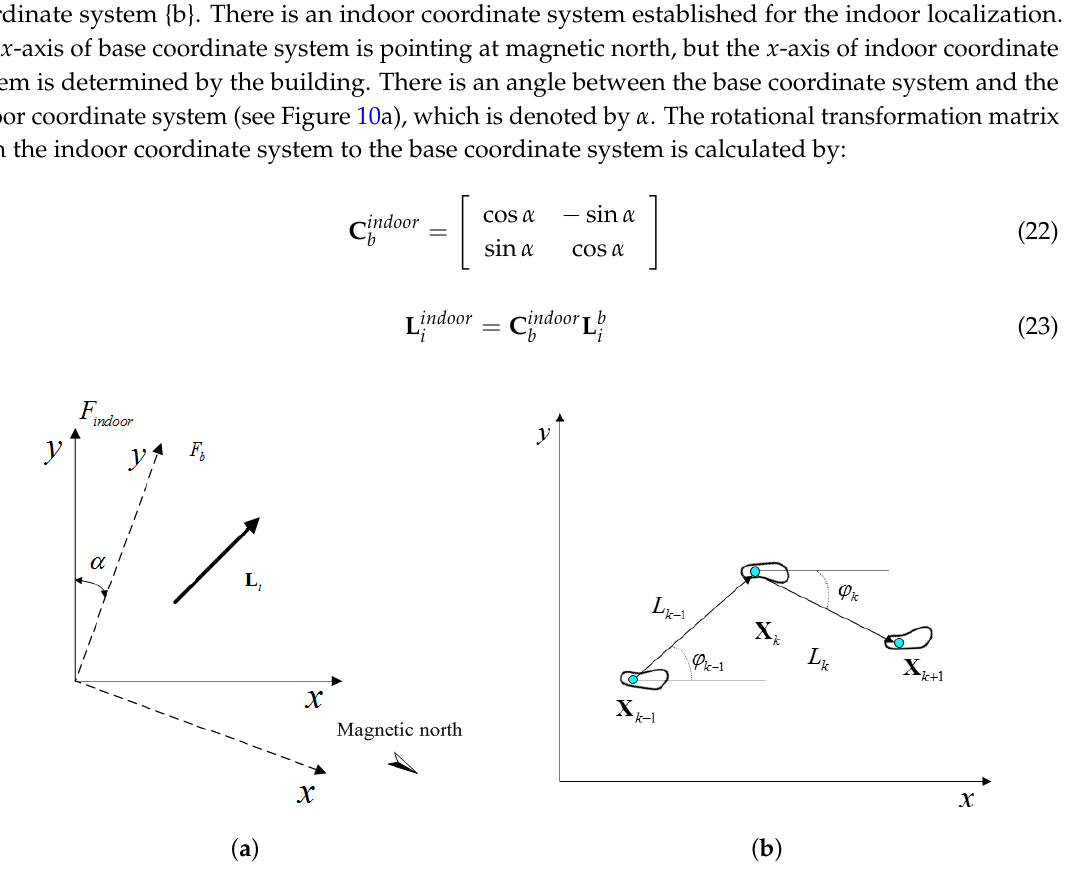
Figure 10. The coordinate definition of the indoor localization subsystem. ( a ) Indoor coordinate system and base coordinate system.; ( b ) Updating of localization